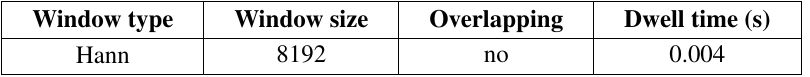
Table 2: Parameters used for the computation of the experimental